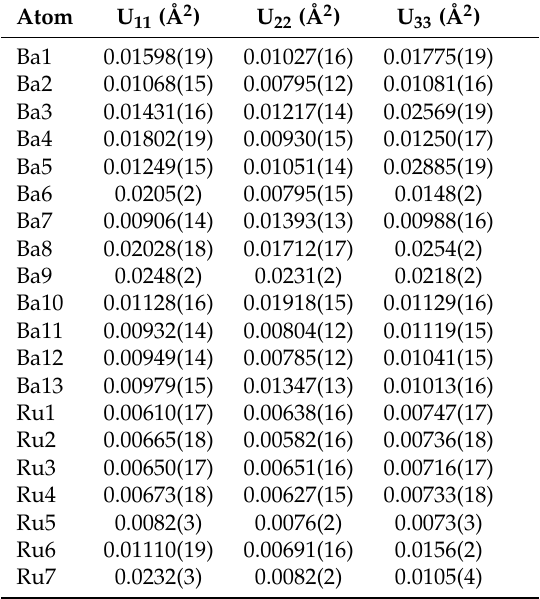
Table 3. Refinement results of single crystal X-ray diffraction measurements of Ba 26 Ru 12 O 57